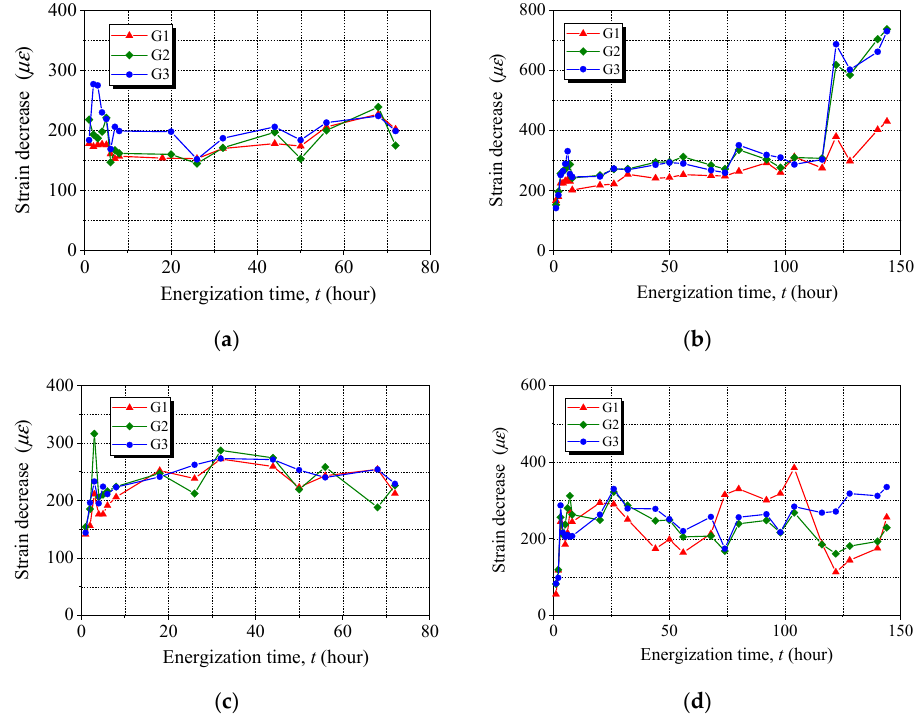
Figure 5. Strain evolution of anchored CFRP laminates during accelerated corrosion. ( a ) C-72. ( b ) C-144. ( c ) W-72. ( d ) W-144.